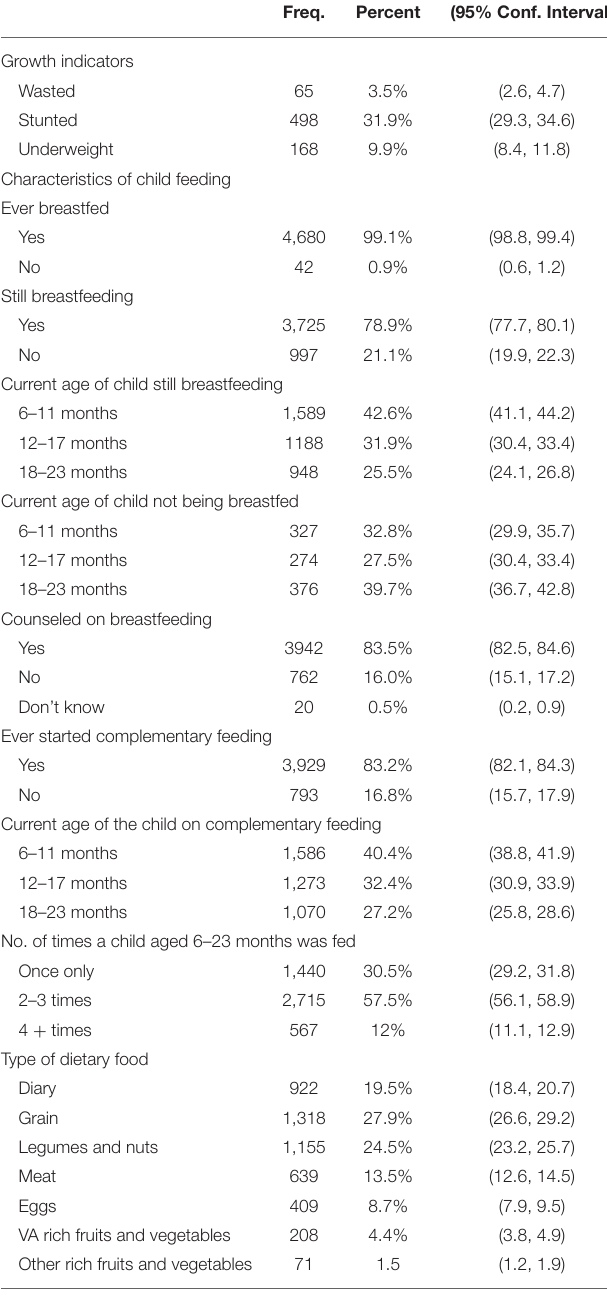
TABLE 2 | Proportion of infants and young children meeting the four TABLE 1 | Characteristics of complementary feeding and growth indicators WHO/UNICEF feeding indicators in 2015–16. among the 4,722 children 6–23 months old from the 2015–16 MDHS. Freq. (95% Conf. Interval) Indicator